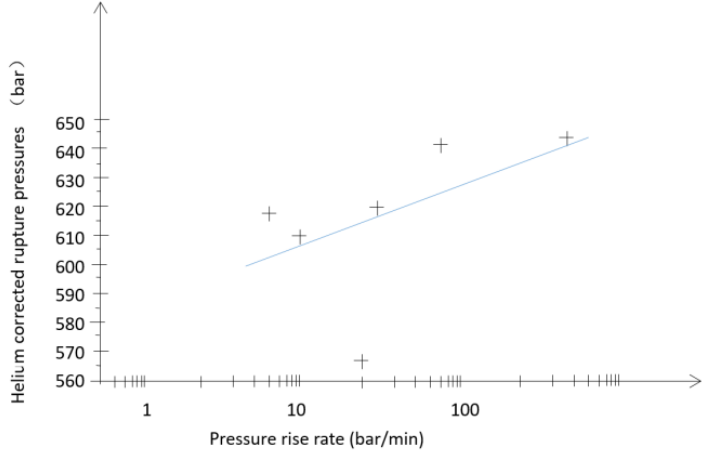
Figure 5. Variation in corrected helium rupture pressures as a function of the p ressure rise rate. The + sign indicate helium rupture pressure in different pressure rise rate.